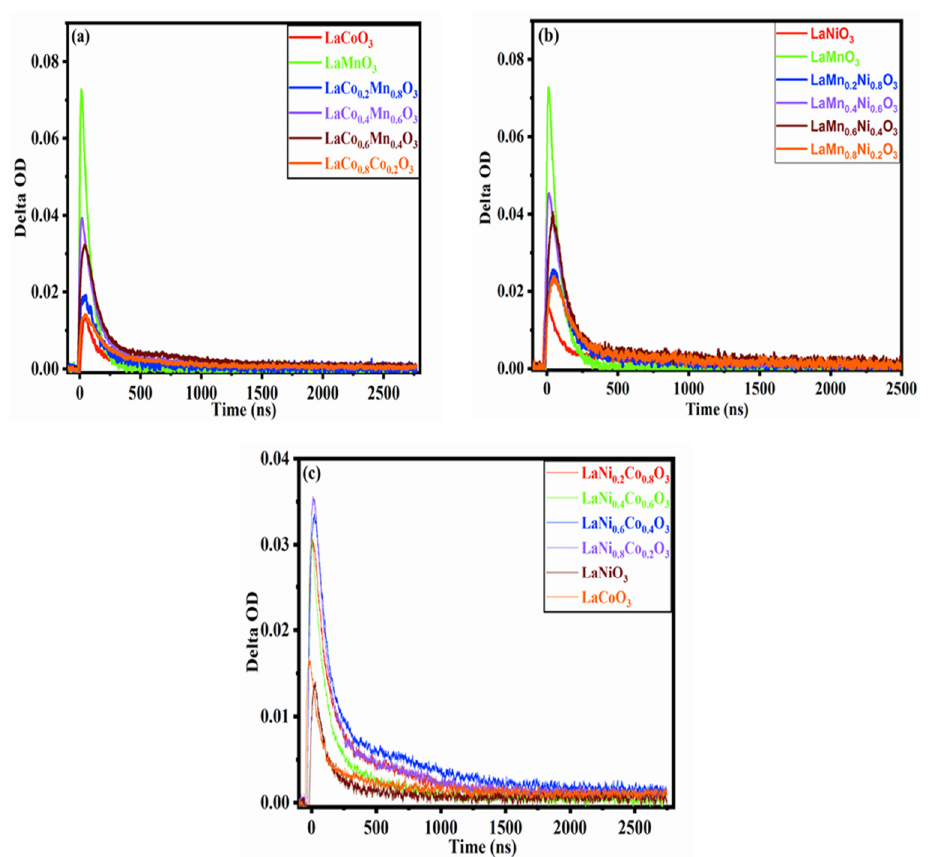
Figure 6. The TAS decay trace recorded following the UV excitation (1.29 mJ, 355 nm, 10 HZ) of ( a ) LaCo x Mn 1 − x O 3 , ( b ) LaMn x Ni 1 − x O 3 ( c ) and LaNi x Co 1 − x O 3 (x = 0, 0.2, 0.4, 0.6, 0.8 and 1.0) in the presence of a chemical scavenger (CH 3 OH). presence of a chemical scavenger (CH 3